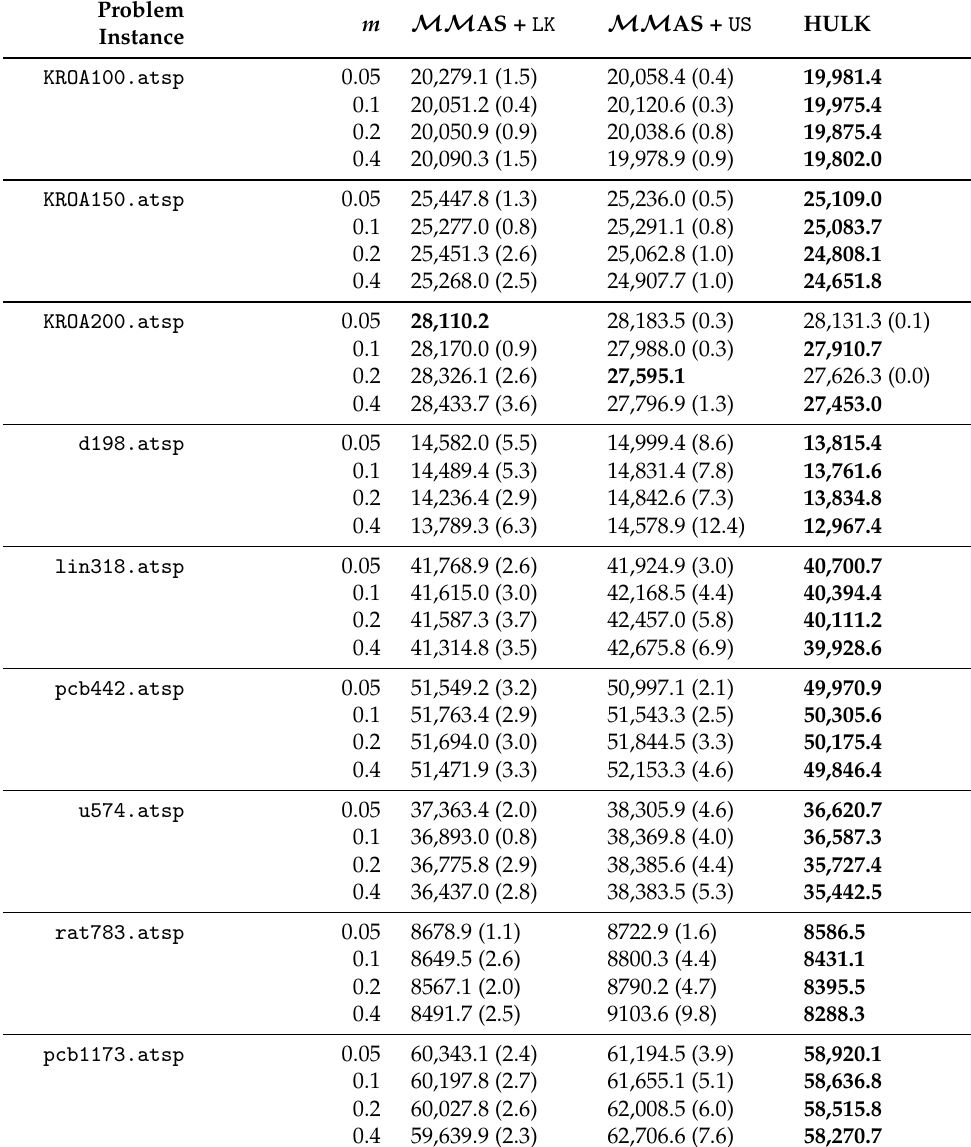
Table 4. Experimental results regarding the average offline performance of the presented methods asymmetric DTSPs. The number between brackets means the distance in percentage from the current value to the best value, in